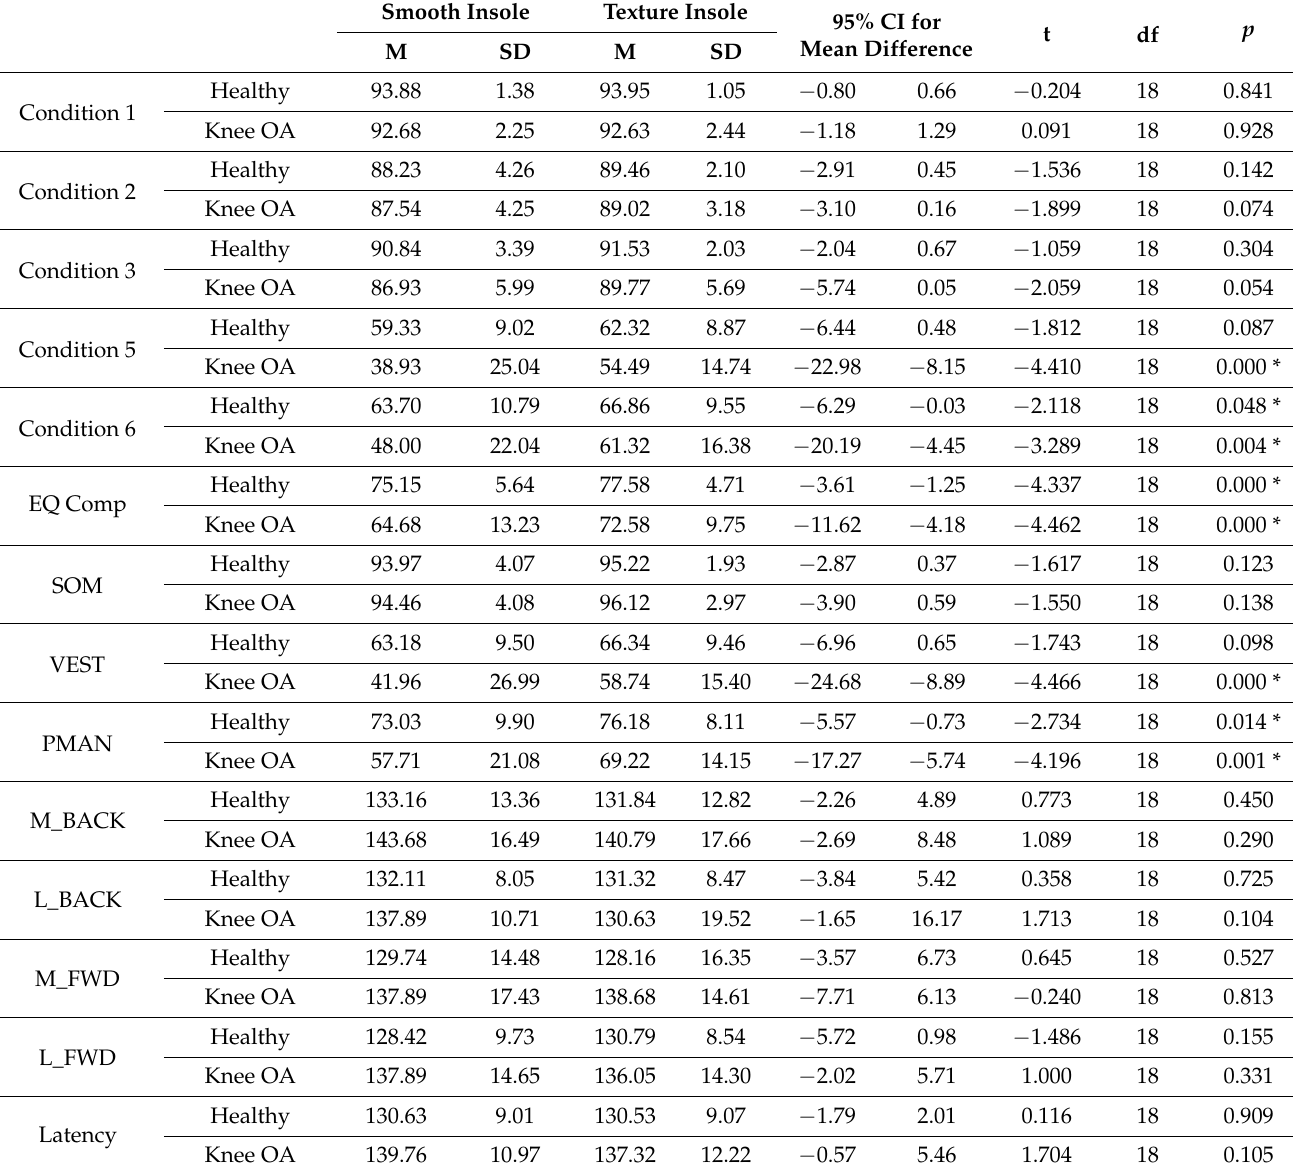
Table A4. Paired t tests results. (Null hypothesis: there are no textured insole effects in the balance.) Smooth Insole